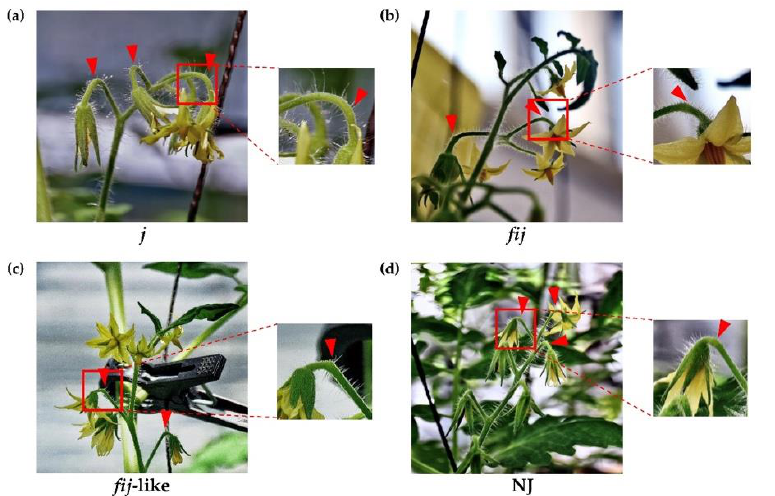
Figure 1. Phenotype of abscission zones (AZ) in four tomato abscission variants. ( a ) jointless (j), ( b ) functionally impaired jointless (fij), ( c ) functionally impaired jointless like (fij like), and ( d ) normal joint (NJ). Various flower developmental stages, except for the j, were used to obtain samples of abscission zones (AZs) and nonabscission zones (NAZs). Arrowheads indicate the junction of AZs in each variant.